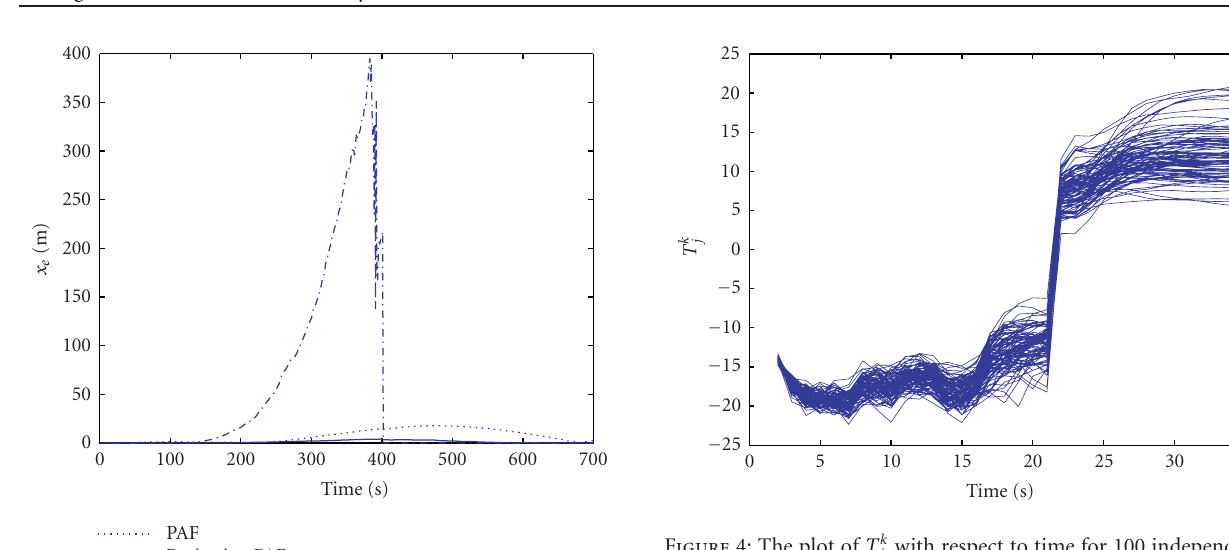
Figure 4: The plot of T k with respect to time for 100 independent j runs of an INS/GSP system. At time t = 15, the receiver loses three satellites. The cycle slip in channel one occurred at t = 20seconds.